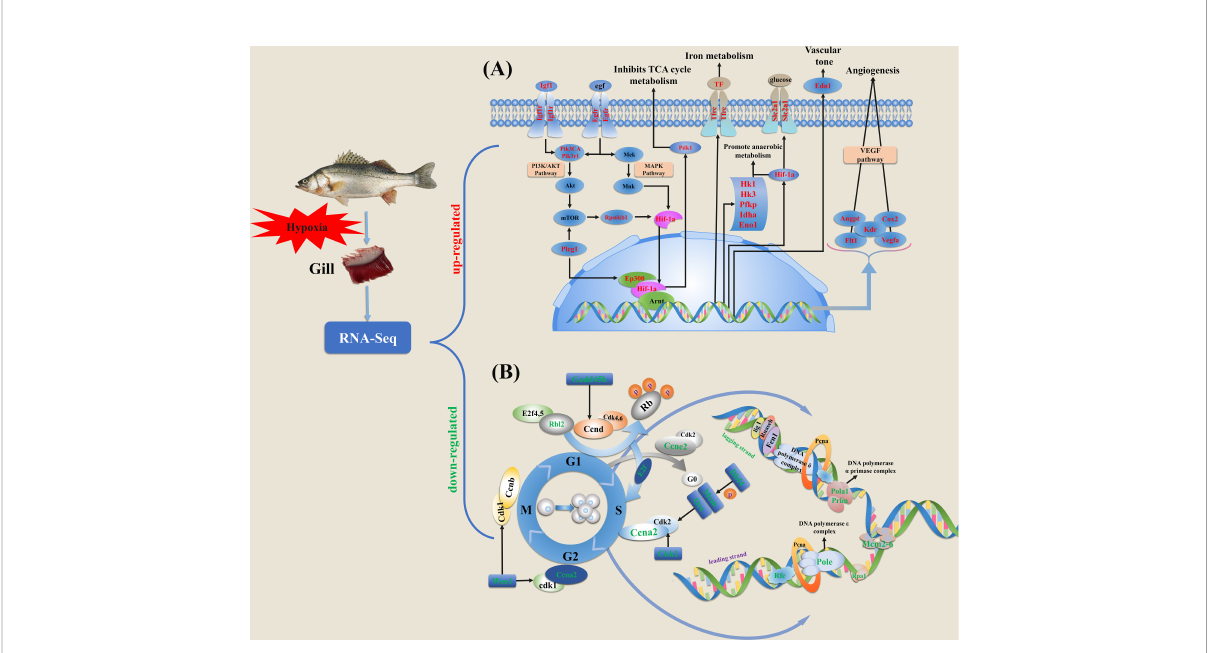
FIGURE 5 Schematic diagram of key genes and pathways in response to hypoxia based on the expression pro fi les in gills of spotted sea bass. (A) The genes involved in HIF-1 signal network system were signi fi cantly induced by hypoxia. (B) The genes involved in cell cycle progression were signi fi cantly suppressed by hypoxia stress. Cell cycle is generally consisted of four different phases, including M, S, G1 and G2. DEGs in HIF-1 signal network system and cell cycle progression were labeled with red and green texts, respectively. The detailed information of these genes involved in HIF-1 signaling pathway and cell cycle are given in Supplementary Tables 3, 4,